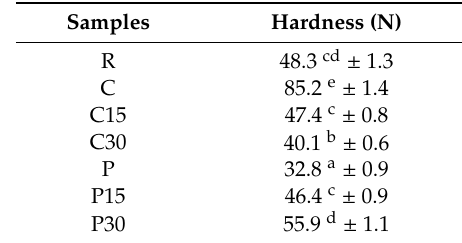
Table 1. Hardness values of co-extruded snacks. Mean ( n = 35) ± SEM. Di ff erent letters in the column